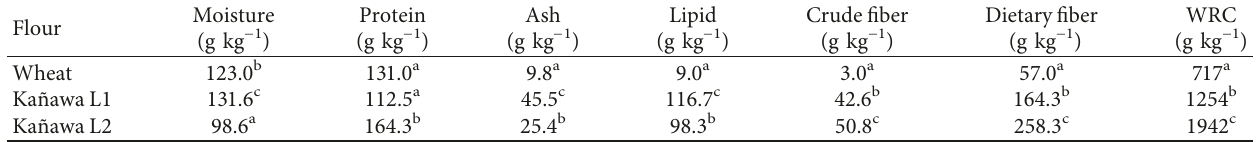
Table 1: Physicochemical properties of wheat and whole kañawa flours ∗ .